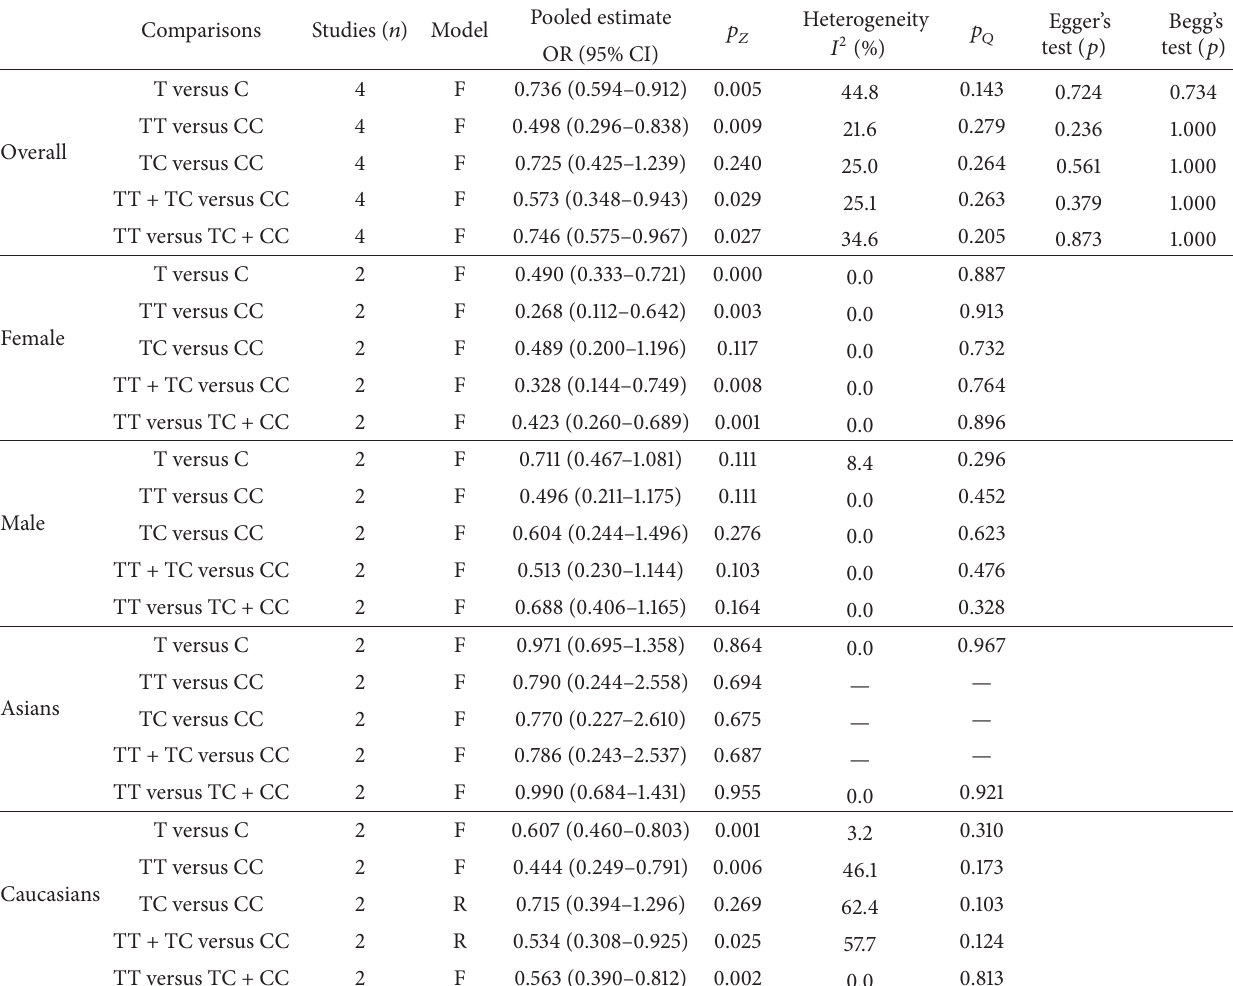
Table 3: Summary risk estimates for association between eNOS rs2070744 and